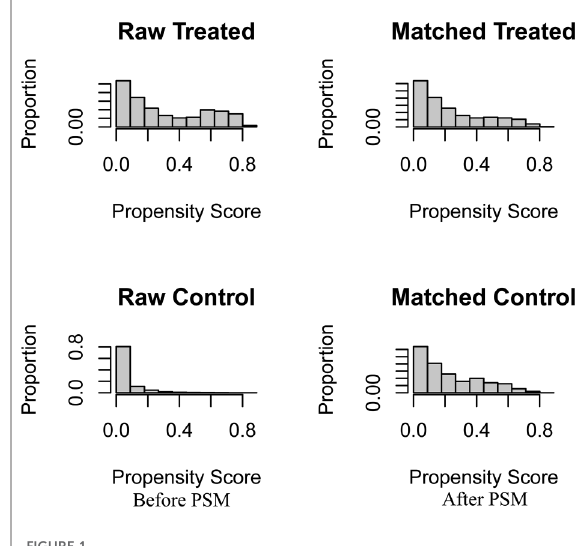
FIGURE 1 Before and after changes in propensity score matching between the CDS and No-CDS groups. CDS: cancer-directed surgery, PSM: propensity score